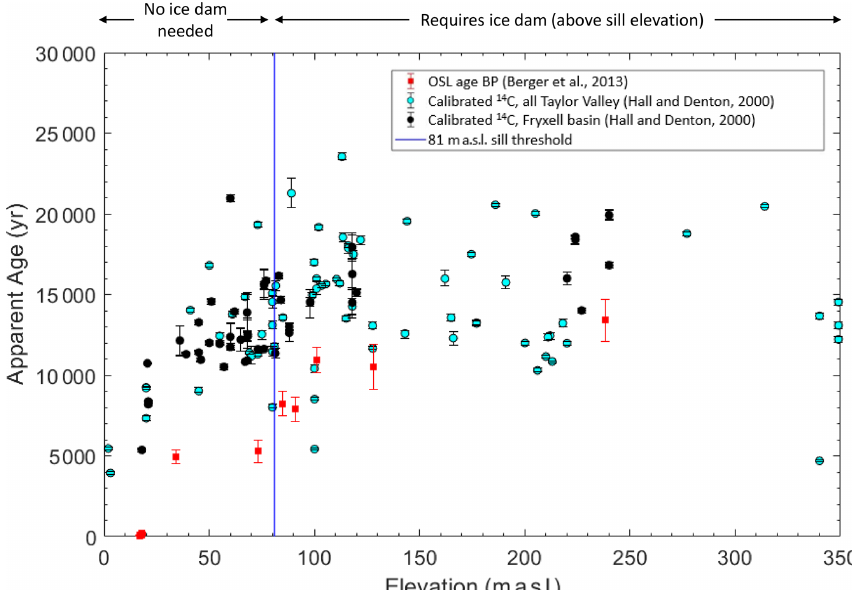
Figure 4. Age of delta deposits from 14 C dating of preserved algal mats (Hall and Denton, 2000) shown as circles with associated error bars (age). Samples from all of Taylor Valley and just Fryxell basin shown as cyan and black circles, respectively. Age estimates using optically stimulated luminescence (OSL) dating shown as red squares with associated error bars (age) (Berger et al., 2013). The vertical blue line represents approximate elevation of sill at Coral Ridge (81ma.s.l.), defining the elevation at which any lake level above would require an ice dam. The calibrated 14 C ages from Hall and Denton (2000) were corrected using the CALIB program (Stuiver et al., 2018).